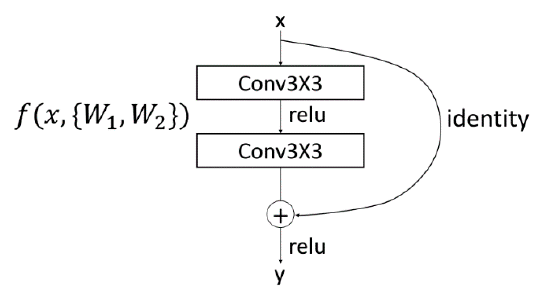
Figure 1. The building block of a residual network.